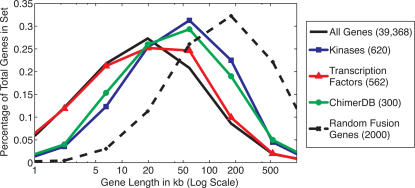
Distribution of gene sizes for different groups of genes.All genes: The “known genes” track in the UCSC Genome Browser [27]. Kinases: Selected from the KinBase database [36]. Transcription factors: Selected from the AmiGO database according to the GO term “transcription factor activity” [37]. ChimerDB: Fusion genes in cancer extracted from the chimerDB database [23]. Random Fusion Genes: A set of 2000 genes involved in 1000 random fusion events. Random Fusion events were formed by inducing random breakpoints, and selecting such events if they formed a fusion gene. Note that the gene sizes are on a log scale, and the number of genes from each set used to derive each distribution is shown in the legend.